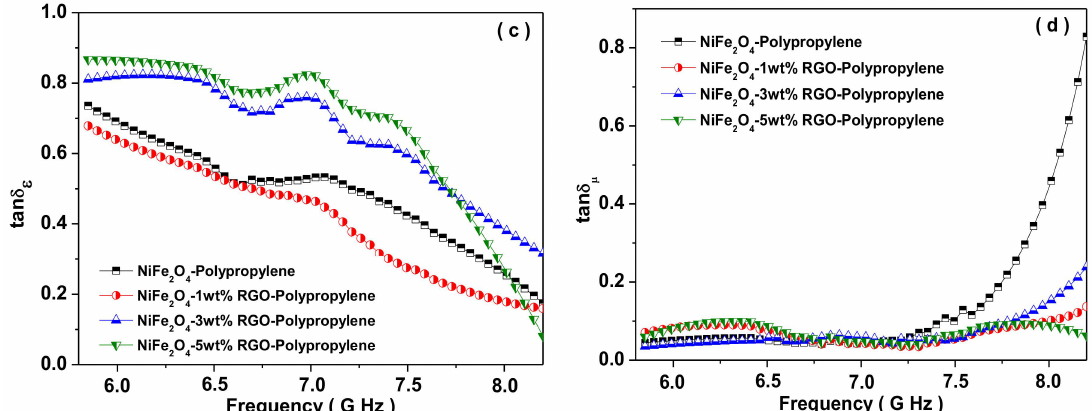
Figure12. ( a )Realpartofthepermeability,( b )imaginarypartofthepermeability,( c )dielectriclosstan δ ε ,and ( d ) magnetic loss tan δ µ for NiFe 2 O 4 -Polypropylene, NiFe 2 O 4 -1wt%RGO-Polypropylene, NiFe 2 O 4 -3wt% RGO-Polypropylene, and NiFe 2 O 4 -5wt% RGO-Polypropylene elastomer